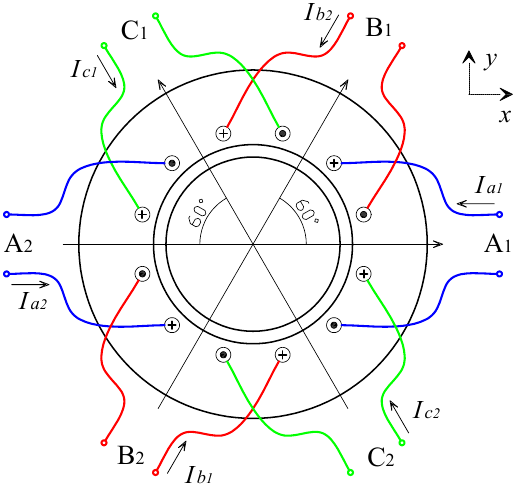
Figure 2. Arrangement of the windings in the